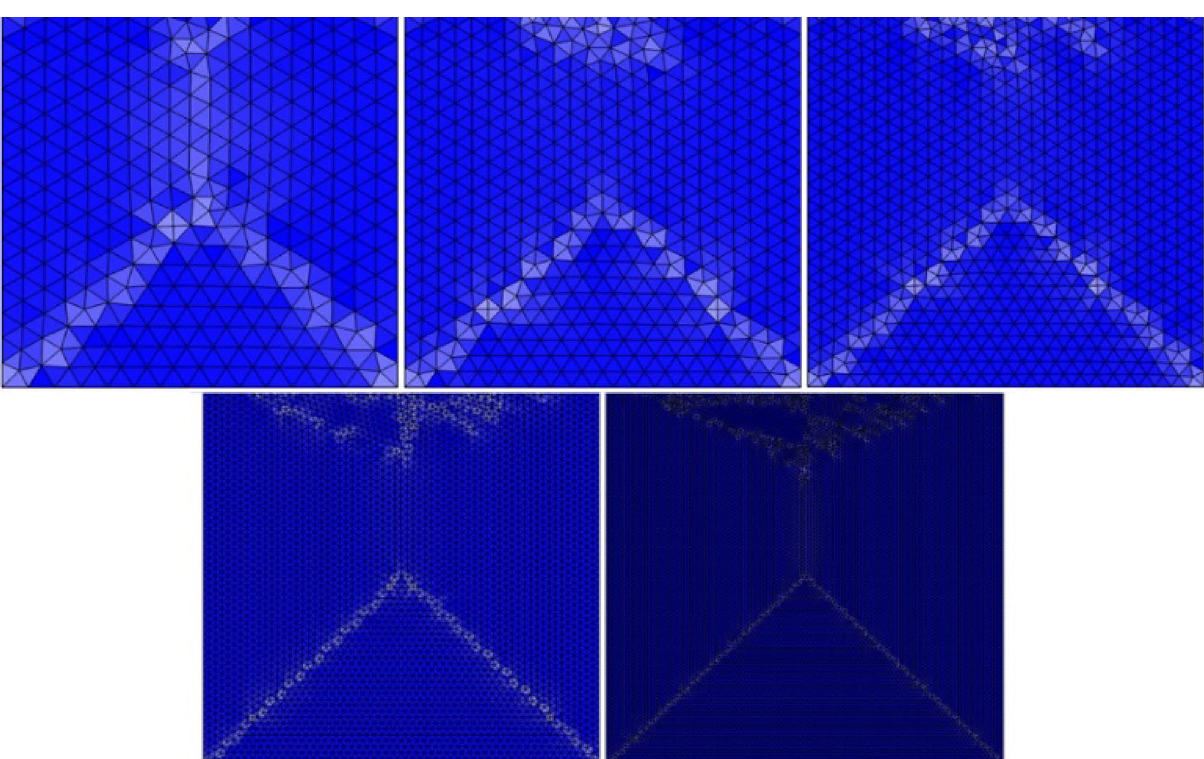
Figure 2. The meshing process in the cavity from coarse to extremely fine